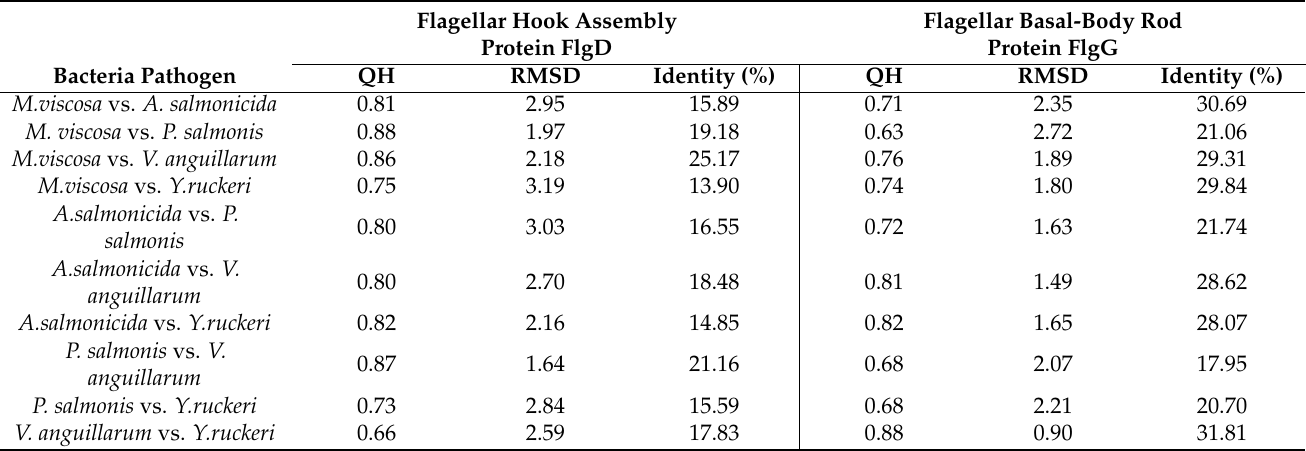
Table 4. Sequence and structural alignment of the common secreted antigens. QH, structural homology; RMSD, root mean square